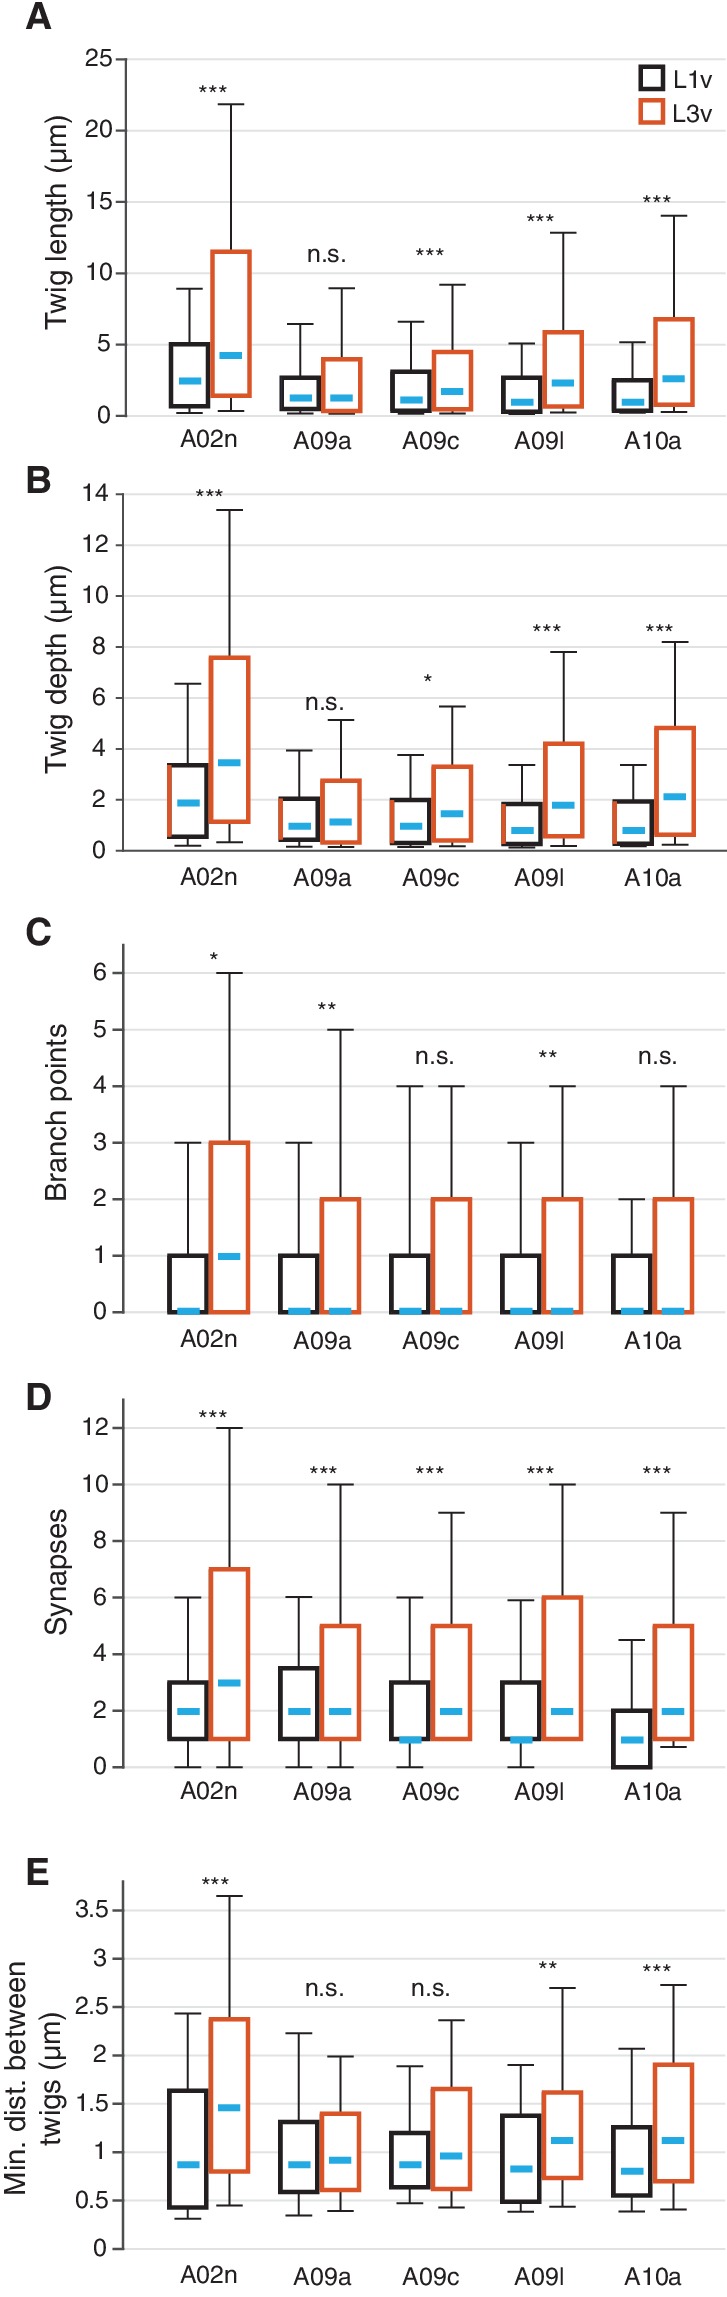
Individual twig properties, broken down by LN cell type.For each panel, bars indicate interquartile intervals, whiskers show 5/95 percentile lines. White dashes indicate median. Each bar collects twigs from all cells in the cell type, and each twig was weighted equally. (A) Box plots of total cable length per twig by cell type and developmental stage. (B) Box plots of maximum twig depth (distance from distal tip to twig base) by cell type and developmental stage. (C) Box plots of number of branch points per twig by cell type and developmental stage. (D) Box plots of number of input synapses per twig by cell type and developmental stage. (E) Box plots of minimum distance between twig bases along neuronal backbone by cell type and developmental stage. *p<0.05, **p<0.01, ***p<0.001, n.s.: not significant, two-sided t-test with Bonferonni correction.